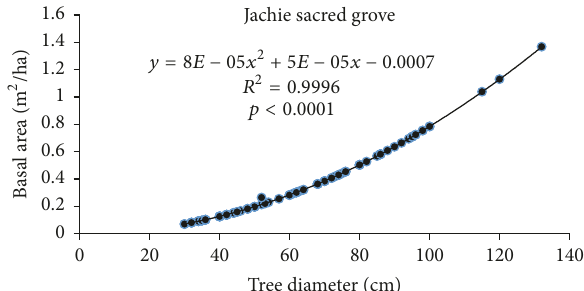
Figure 4: Relationship between tree diameter and basal area in Jachie sacred grove. Notice that the basal area increased with the increase in tree